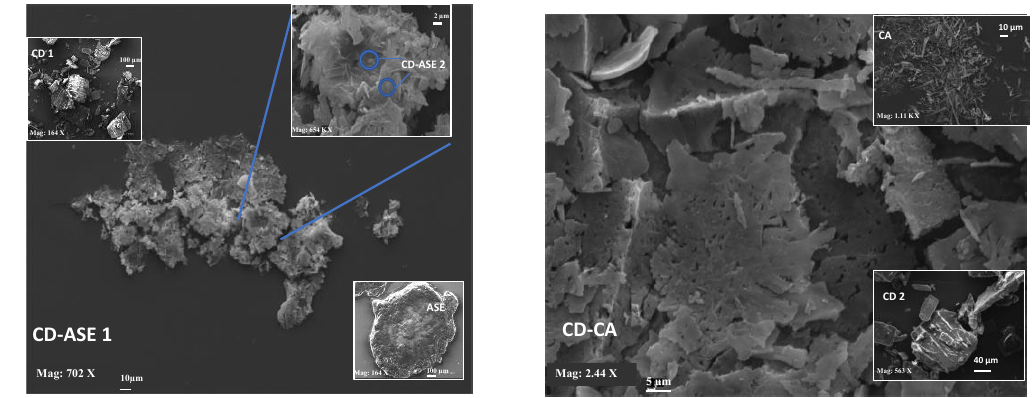
Figure 4. SEM micrographs at different magnifications (Mag) (CD-ASE 1, 702 X; CD-CA, 2.44 KX; CD 1, 164 X; CD 2, 563 X; ASE, 164 X; CD-ASE 2, 654 KX; CA, 1.11 KX; frame average, N = 1) .